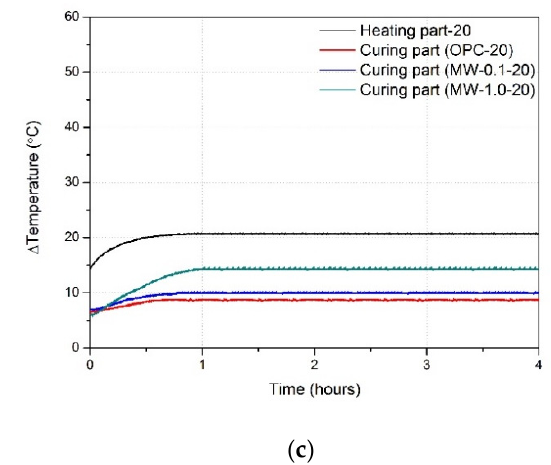
Figure 6. Temperature variation of the specimens with heat curing versus time at a chamber temperature of ( a ) 0 °C, ( b ) − 10 °C, and ( c ) − 20 °C.